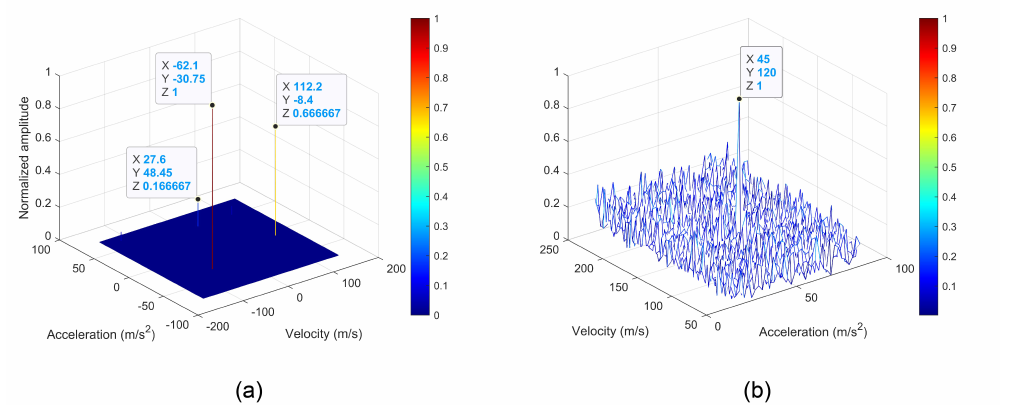
Figure 11. The results of parameter estimation for the proposed method and GRFT at SNR = − 12 dB. ( a ) The result of of parameter estimation for the proposed method. ( b ) The result of of parameter estimation for